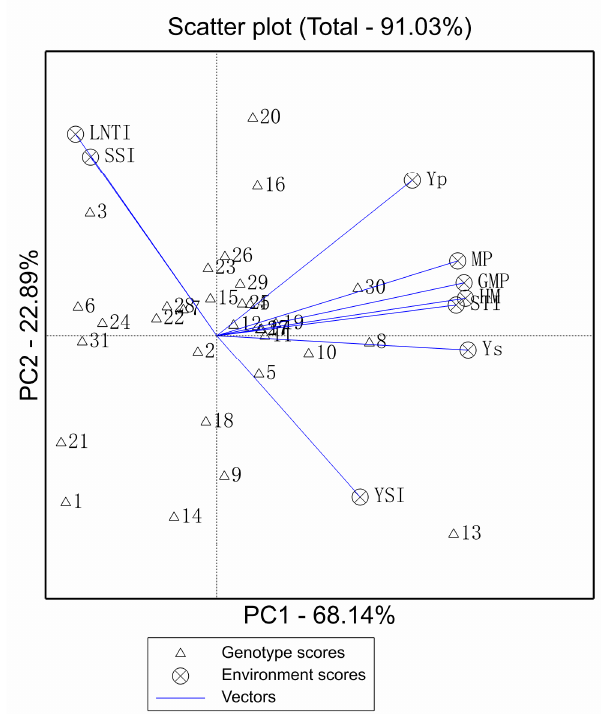
Figure 2. Drawing of the Genotype and genotype × environment (GGE) biplot based on the first (PC1) and the second (PC2) principal component for 31 inbred lines and different indices. Transform = 0, Scaling = 0, Centering = 2, and SVP = 2. Numbers assigned to the genotypes are:(1) KA008; (2) 2012KA-1; (3) KA064; (4) 2012KA -58; (5) KA103; (6) KA203; (7) 2013KA-34; (8) KA105; (9) KA227; (10) KA225; (11) XCA-1; (12)KA060; (13)KB081; (14) KB417; (15) KB109; (16)91227; (17)KB-7; (18) KB020; (19) 2013KB-37; (20) 2013KB-47; (21) KB043;(22)Z140588; (23) Z140580; (24) 2013HXB-4; (25) 2013ZZB-6; (26) 2014KB-54; (27) KB215; (28) Zheng58; (29) Chang7-2; (30) PH6WC; and (31) PH4CV. Dotted vertical and horizontal lines indicate points where the PC1 and PC2 axes had values of zero. Smaller vectors angles indicate a larger correlation value, a positive correlation exists, when the angle is less than 90°, and a negative correlation when greater than 90°.